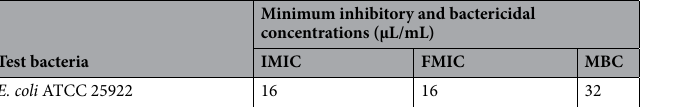
Table 2. Minimum inhibitory concentration (MIC) and minimum bactericidal concentration (MBC) of limonene against reference strains. IMIC initial minimum inhibitory concentration (after 24 h); FMIC final minimum inhibitory concentration (after 48 h); MBC minimum bactericidal concentration.